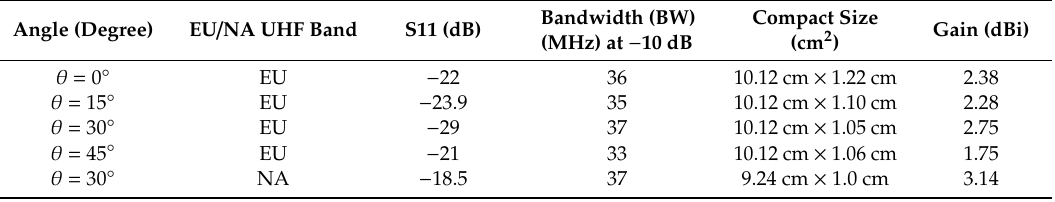
Table 2. Meandering angle characteristics and parameters for both European (EU) and North American (NA) UHF band